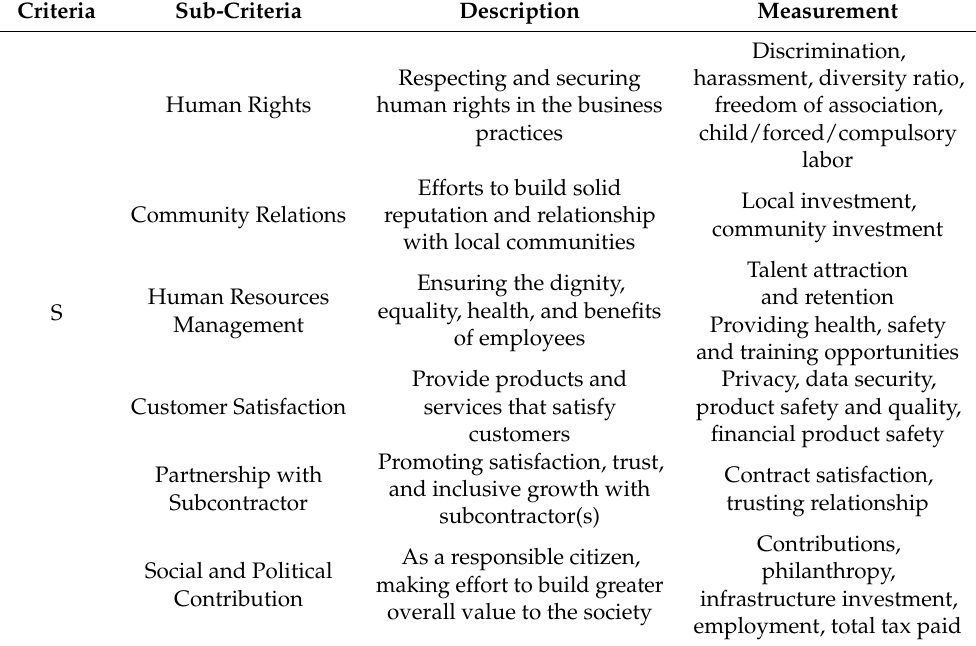
Table A7. Sub-criteria (social factors): definitions and descriptions of key components.